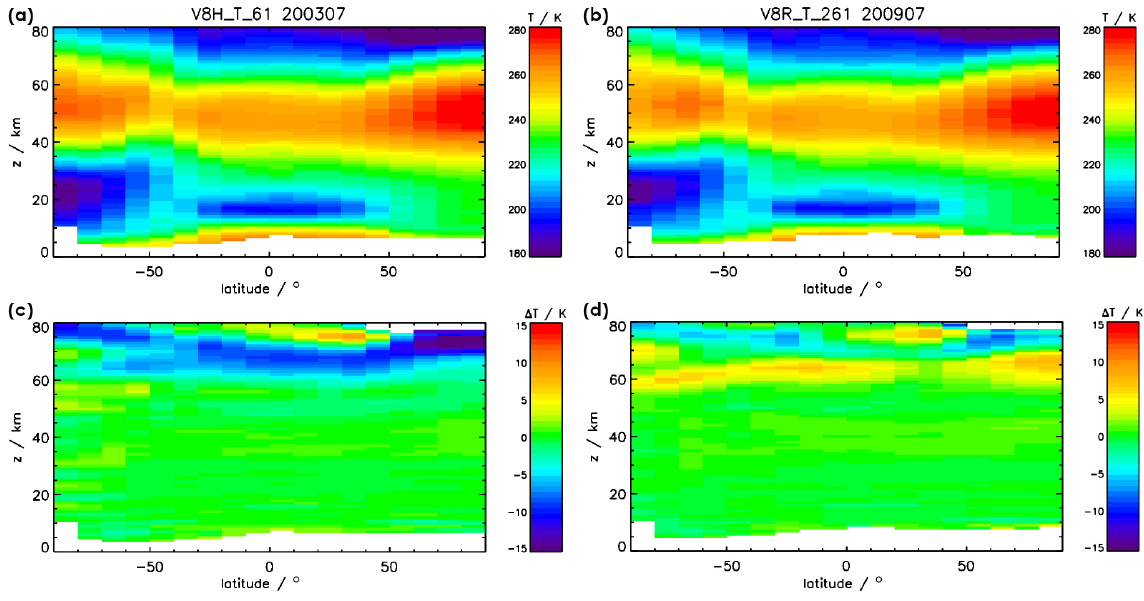
Figure 7. (a, b) Monthly mean V8 temperature in 10 ◦ latitude bins for July 2003 (FR period, a, c ) and July 2009 (RR, b, d ). (c) Differences between V8 and V5 monthly mean temperatures for FR data (July 2003). (d) Differences between V8 and V5 monthly mean temperatures for RR data (July 2009).